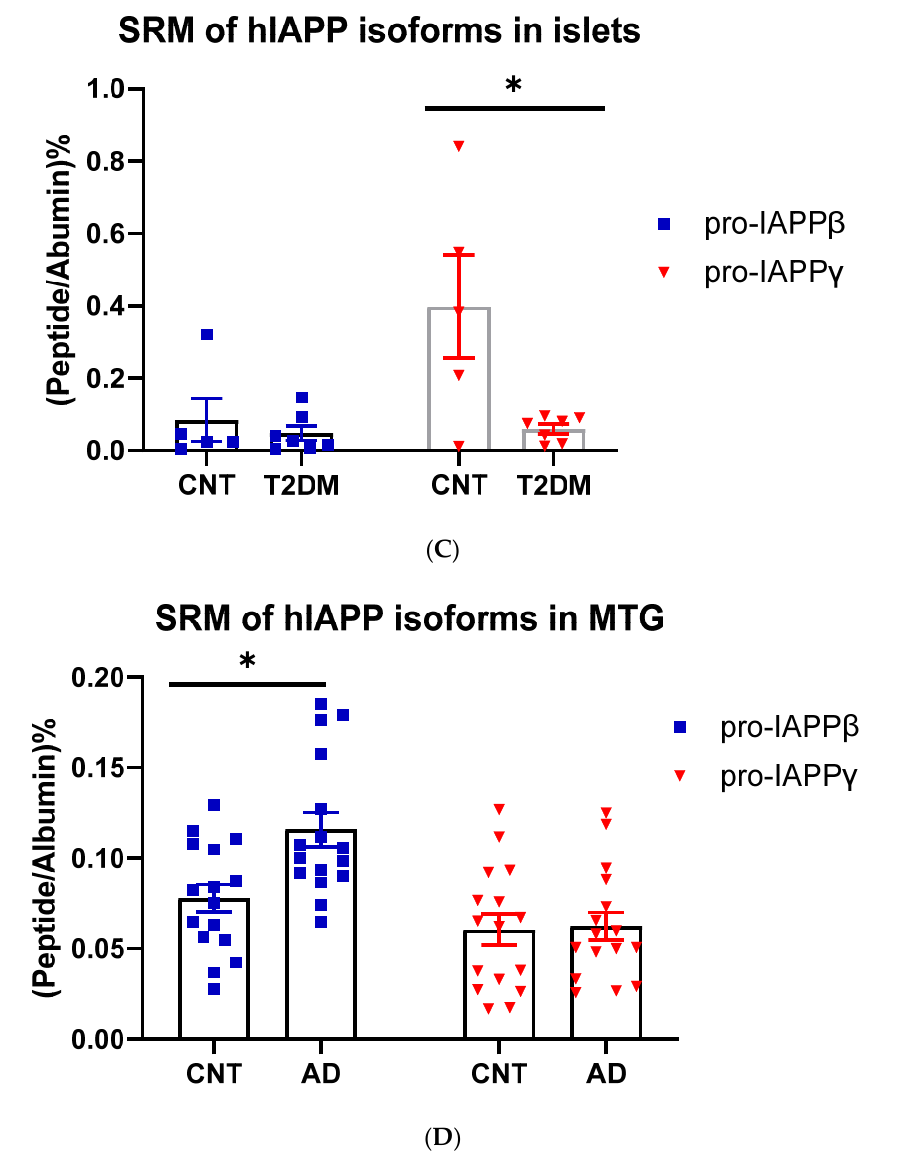
Figure 3. IAPP isoform expression in islets and cerebrum. ( A ) ddPCR of IAPP isoform expression in islets of controls (CNT, n = 14–15, 12–13 fresh islets of close marks and two frozen of open marks) and type 2 diabetes (T2DM, n = 7–8) and ( B ) in the MTG of controls (CNT, n = 15–16) and Alzheimer’s disease (AD, n = 15–16). The Y-axis shows droplets of islet IAPP isoforms normalized to those of GAPDH. ( C ) SRM measurements of pro-IAPP β and pro-IAPP γ at the peptide level in islets of controls (CNT, n = 5) and type 2 diabetes (T2DM, n = 7) and ( D ) in the MTG of controls (CNT, n = 16) and Alzheimer’s disease (AD, n = 16). The Y-axis is the percentage of IAPP isoform peptides normalized to albumin. * represents statistically significant ( p < 0.05).